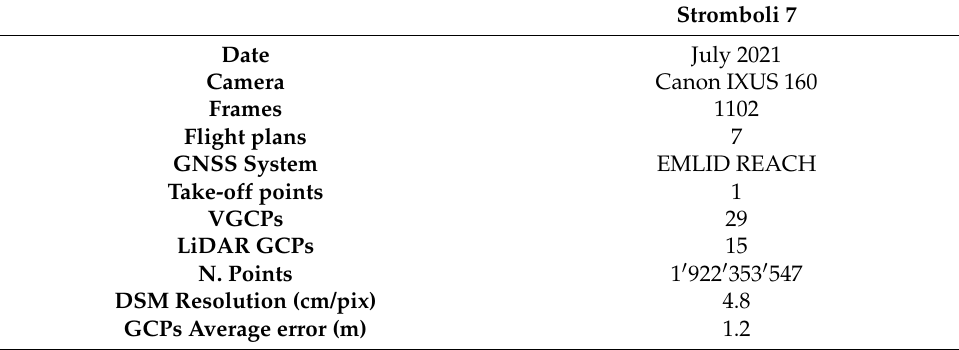
Table 3. Stromboli 7 UAV survey specifications and product